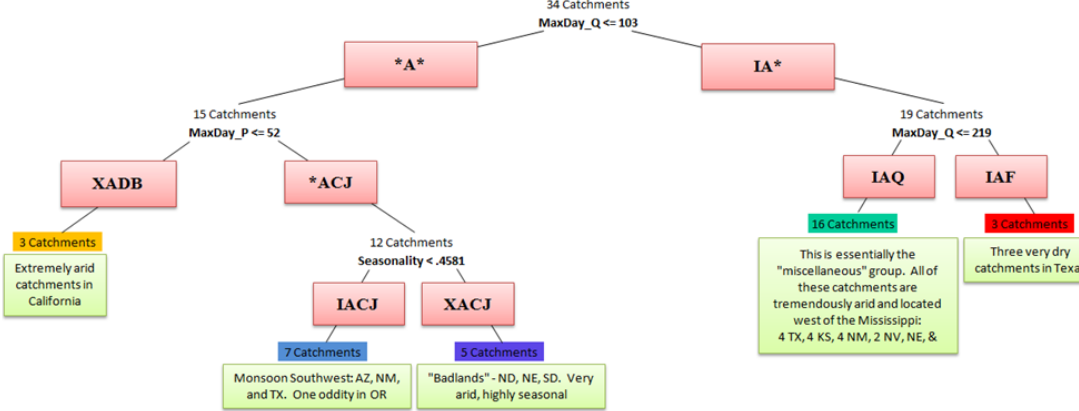
Fig. 12. Higher seasonality, arid: expanded (terminal nodes in blue).